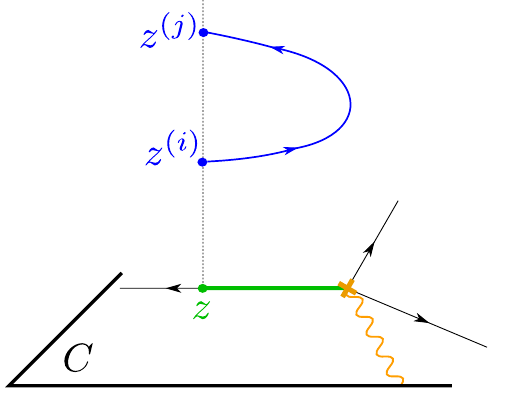
Figure 3. The unique BPS soliton carried by an S -wall in the case of N =